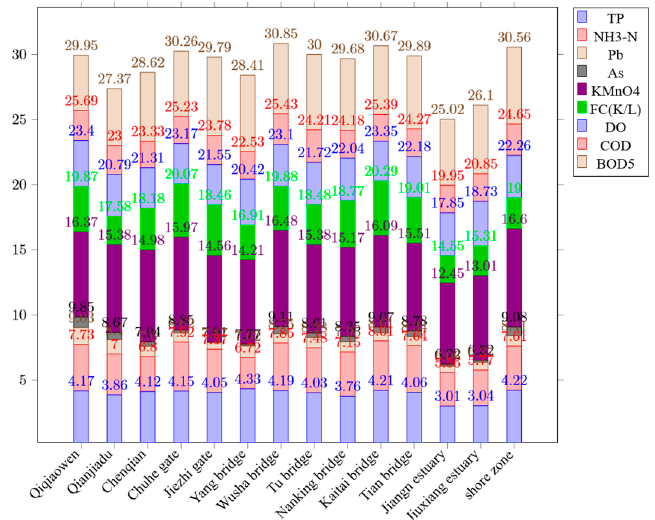
Figure 5. Impact factor illustration.